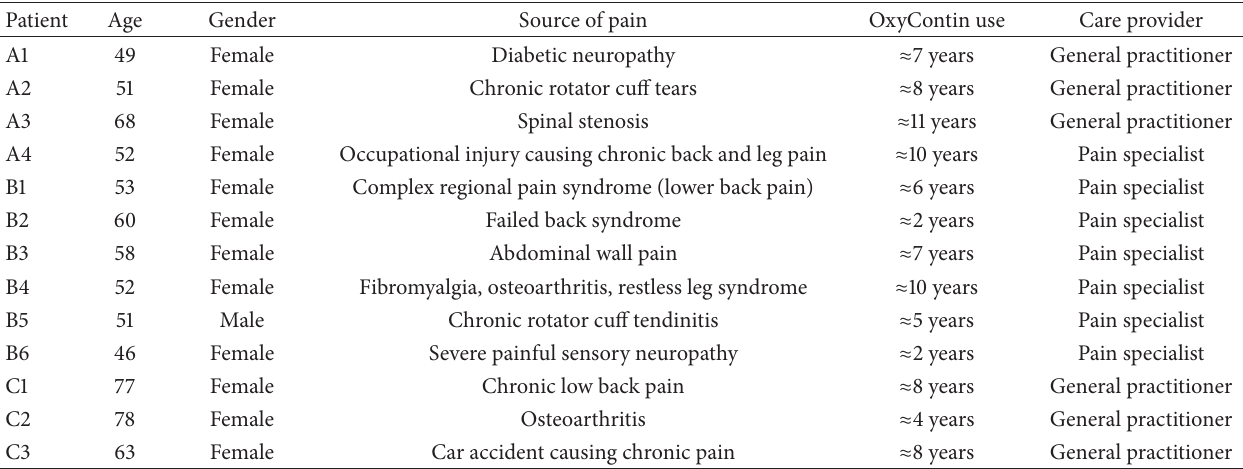
Table 1: General patient